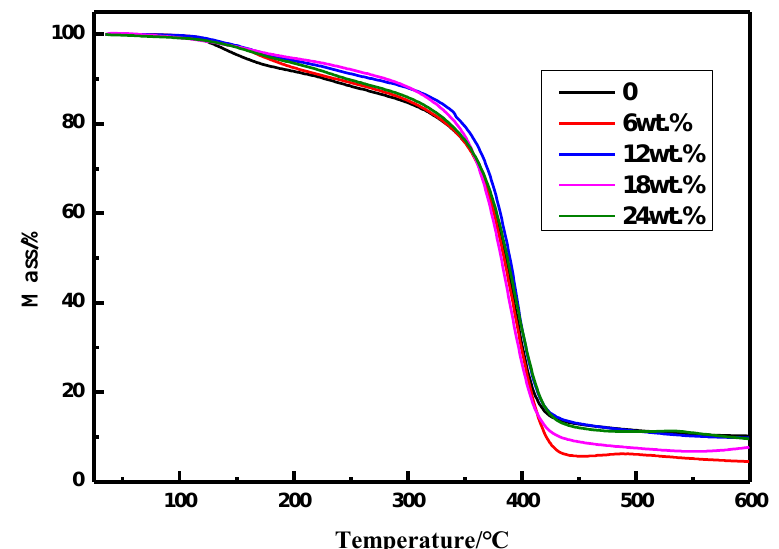
Figure 2. TGA analysis for the coatings. Table 3. Impact of thiol content of silicone resin.